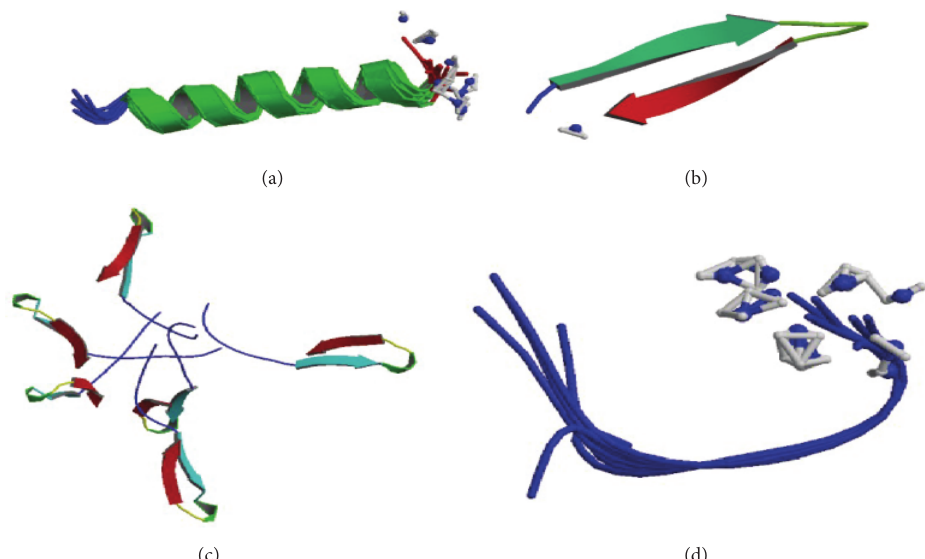
Figure 3: The second structure of antimicrobial peptide. (a) 𝛼 -helical. Source: [5]. (b) 𝛽 -sheet. Source: [6]. (c) Loop. Source: [7]. (d) Extended. Source: